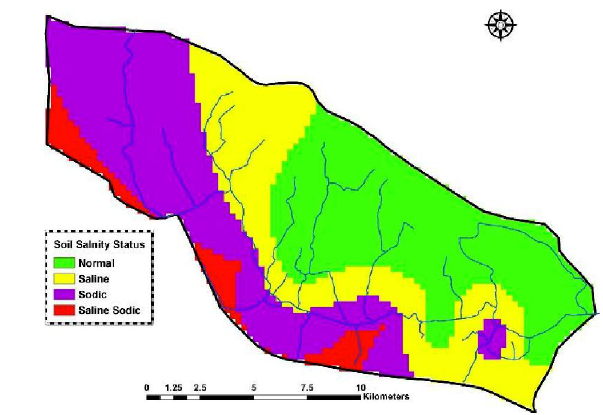
FIG. 13. SPATIAL DISTRIBUTION OF SOIL SALINITY IN THE STUDY